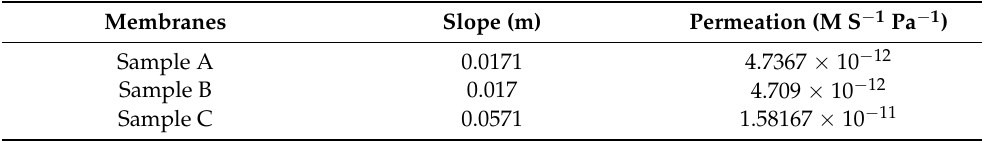
Table 2. Normal deionized water